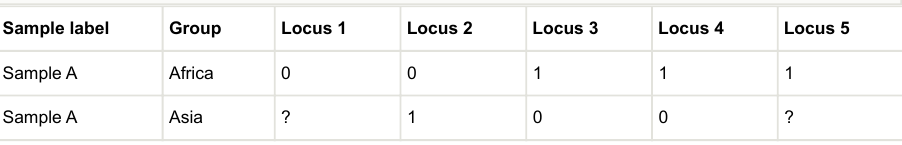
Data input required for the creation of a non-metric multidimensional scaling (nMDS) plot. Grouping information needs to be in the second column. The data here represents binary replicate pairs that have already been consolidated into consensus